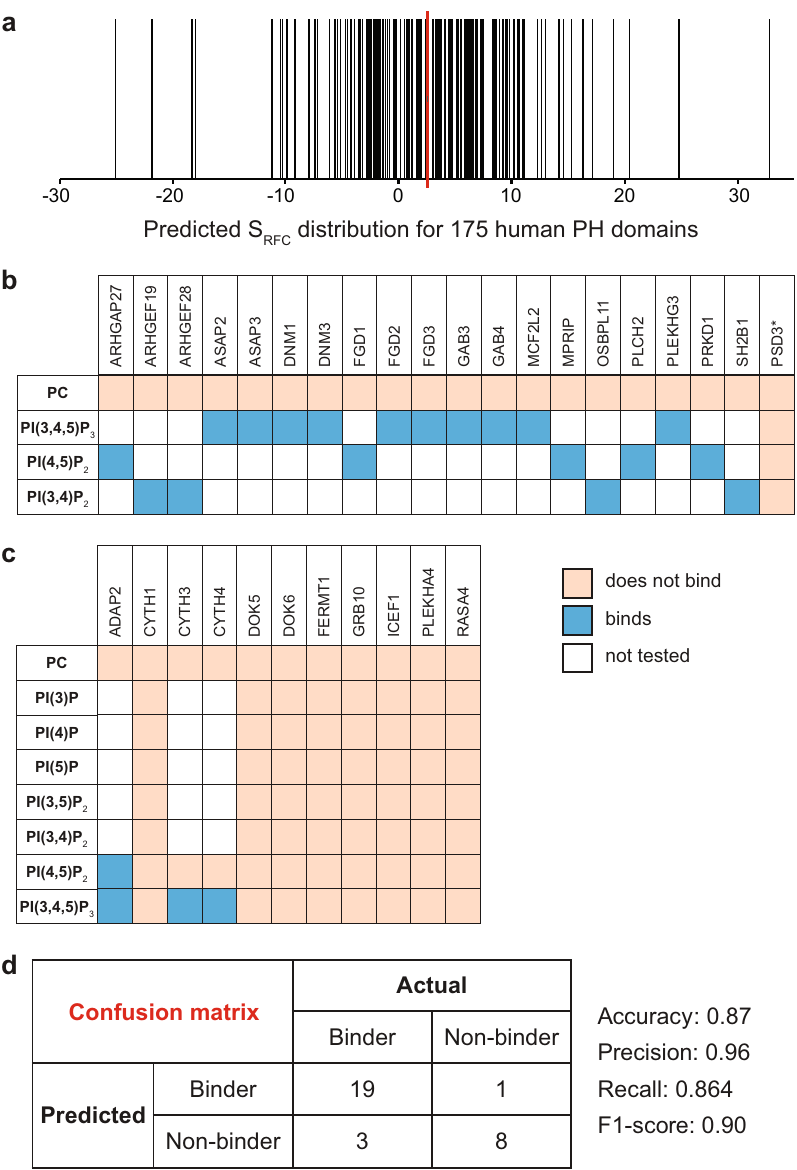
Fig. 7 RFC prediction of PIP binding by human PH domain-containing proteins and validation of the predictions. a Prediction of PIP-binding for 175 human PH domains using the RFC-matrix. Each vertical black line represents one PH domain. The red line indicates the cutoff value (2.59) for PIP-binding. b A binary representation of results of SiMPull assays for 20 predicted PIP binders against various vesicles. *PSD3 was assayed against all 7 PIPs and did not bind any. Blue: binding; peach: no binding; white: not tested. c A binary representation of results of SiMPull assays for 11 predicted PIP non-binders against various vesicles. Blue: binding; peach: no binding; white: not tested. d A confusion matrix constructed with results in ( b , c ), from which various parameters for accuracy metrics are shown. Source data for a are provided as a Source Data fi